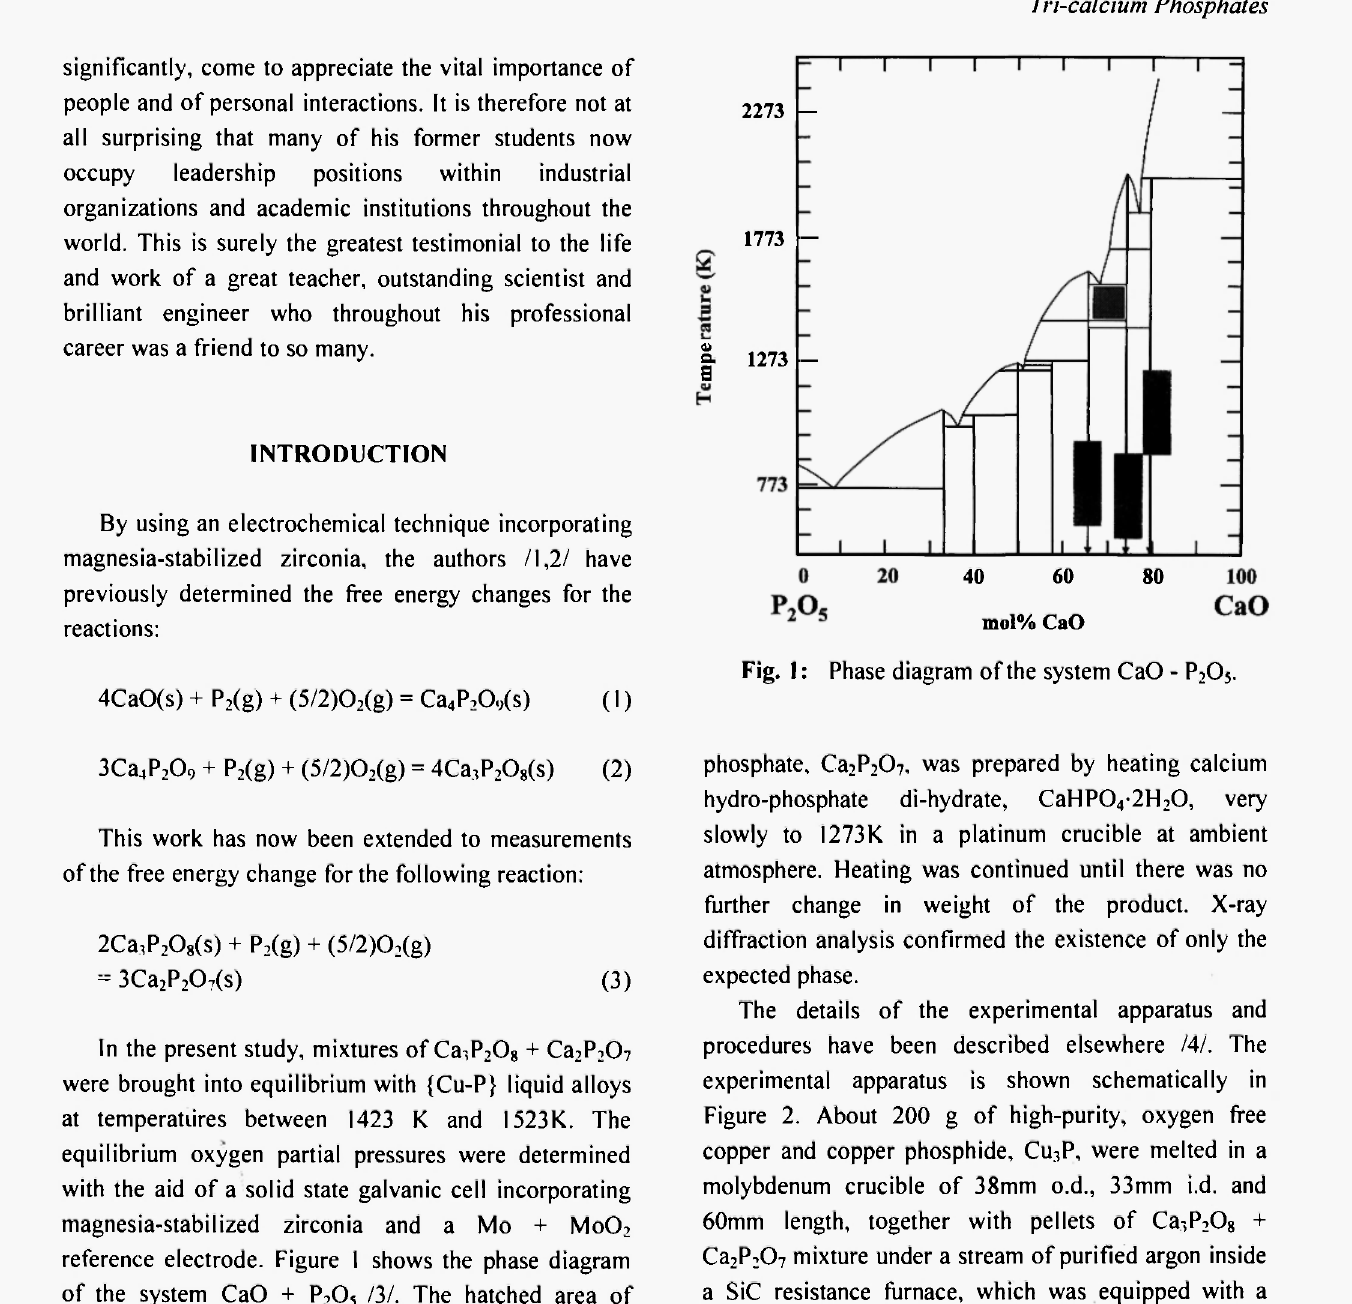
phosphate, Ca 2 P 2 0 7 ,